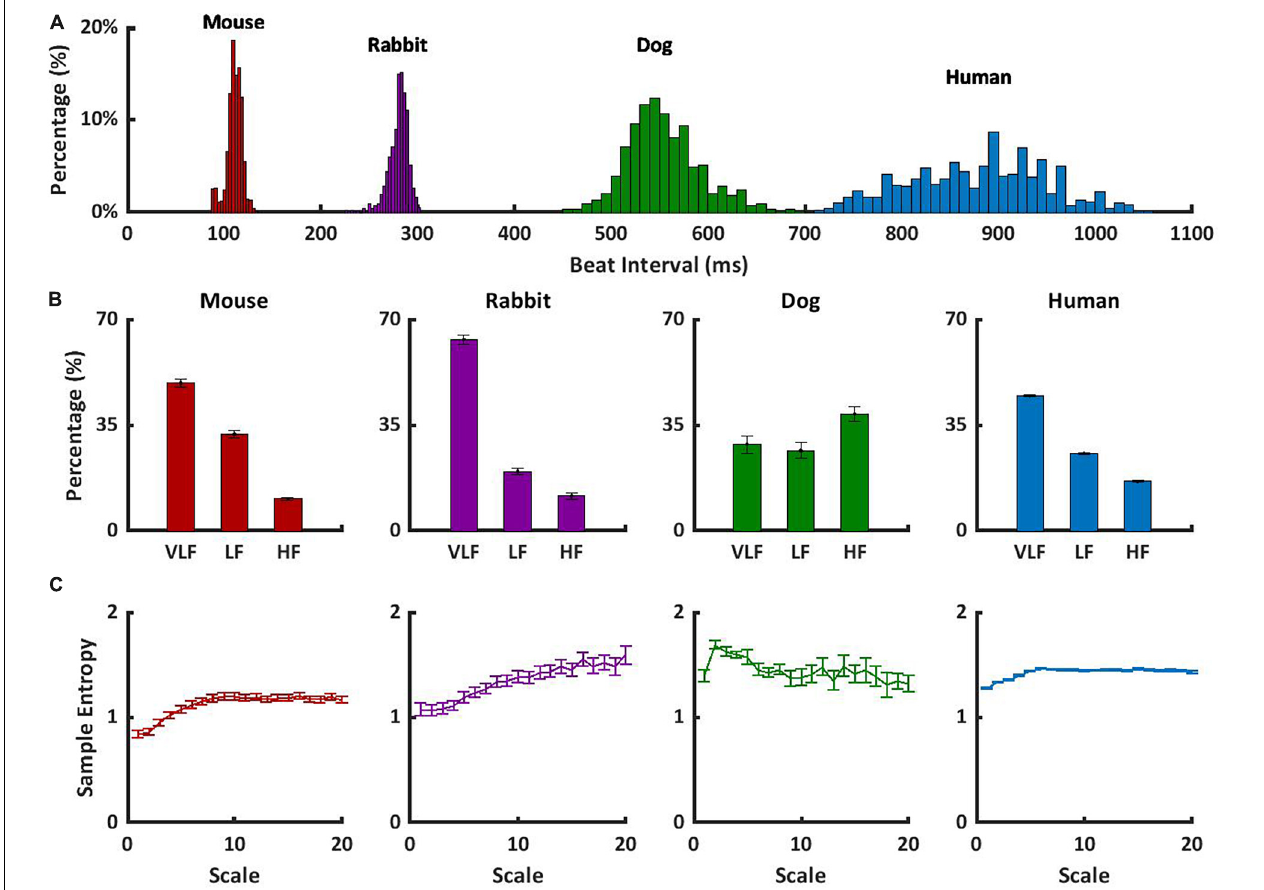
FIGURE 3 | Short- and long-range HRVs in basal HRV in awake mammals. (A) Heartbeat interval histogram for mice, rabbits, dogs, and humans. (B) Normalized power in the VLF, LF, and HF bands, and (C) average multiscale entropy. Frequency and multiscale entropy dog results are from Rosenberg et al. (2020).